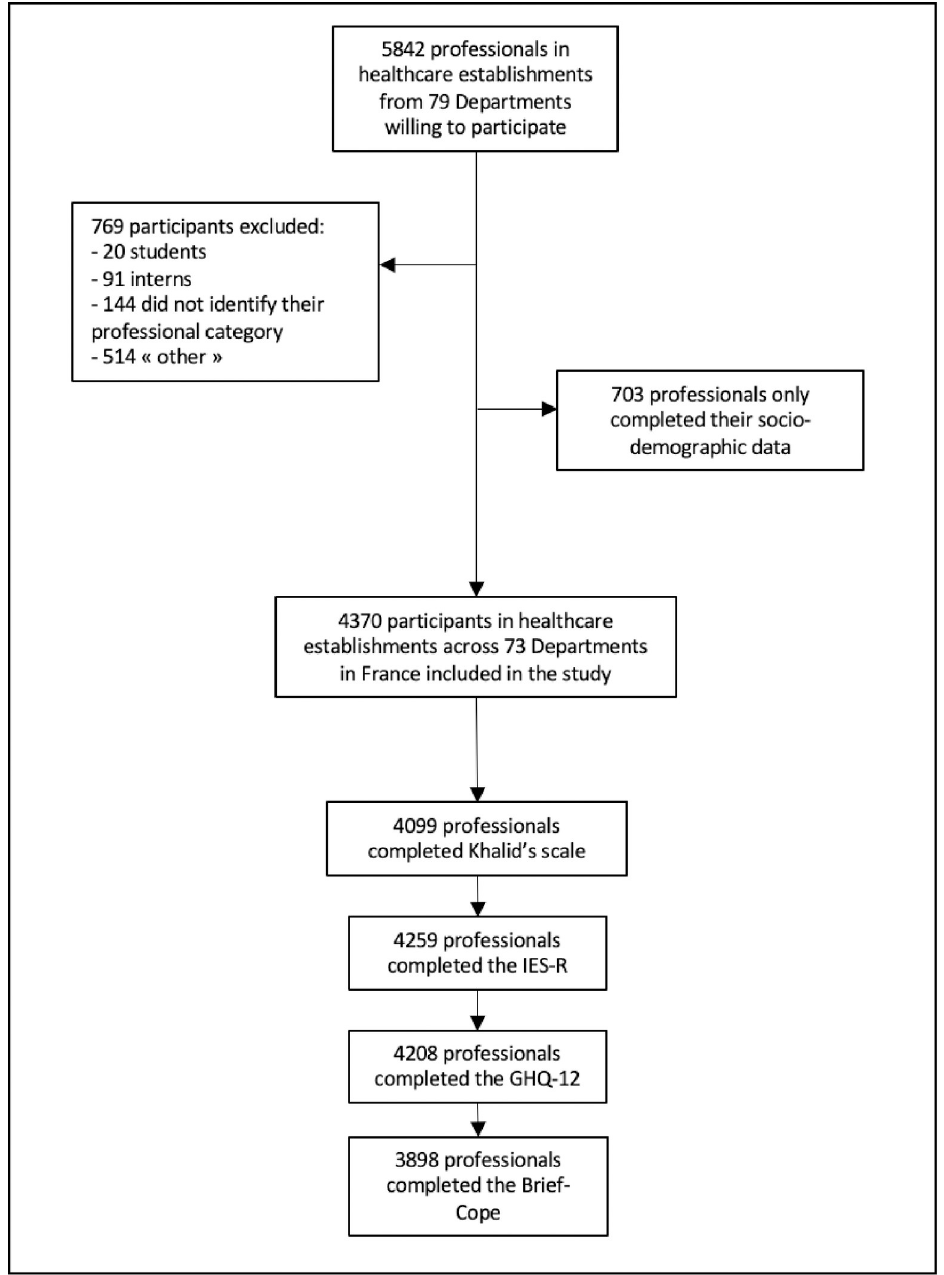
Fig 1. Design of the cross-sectional, multicentre Psy-COVID-All professionals study, performed from 4 June to 22 September 2020.